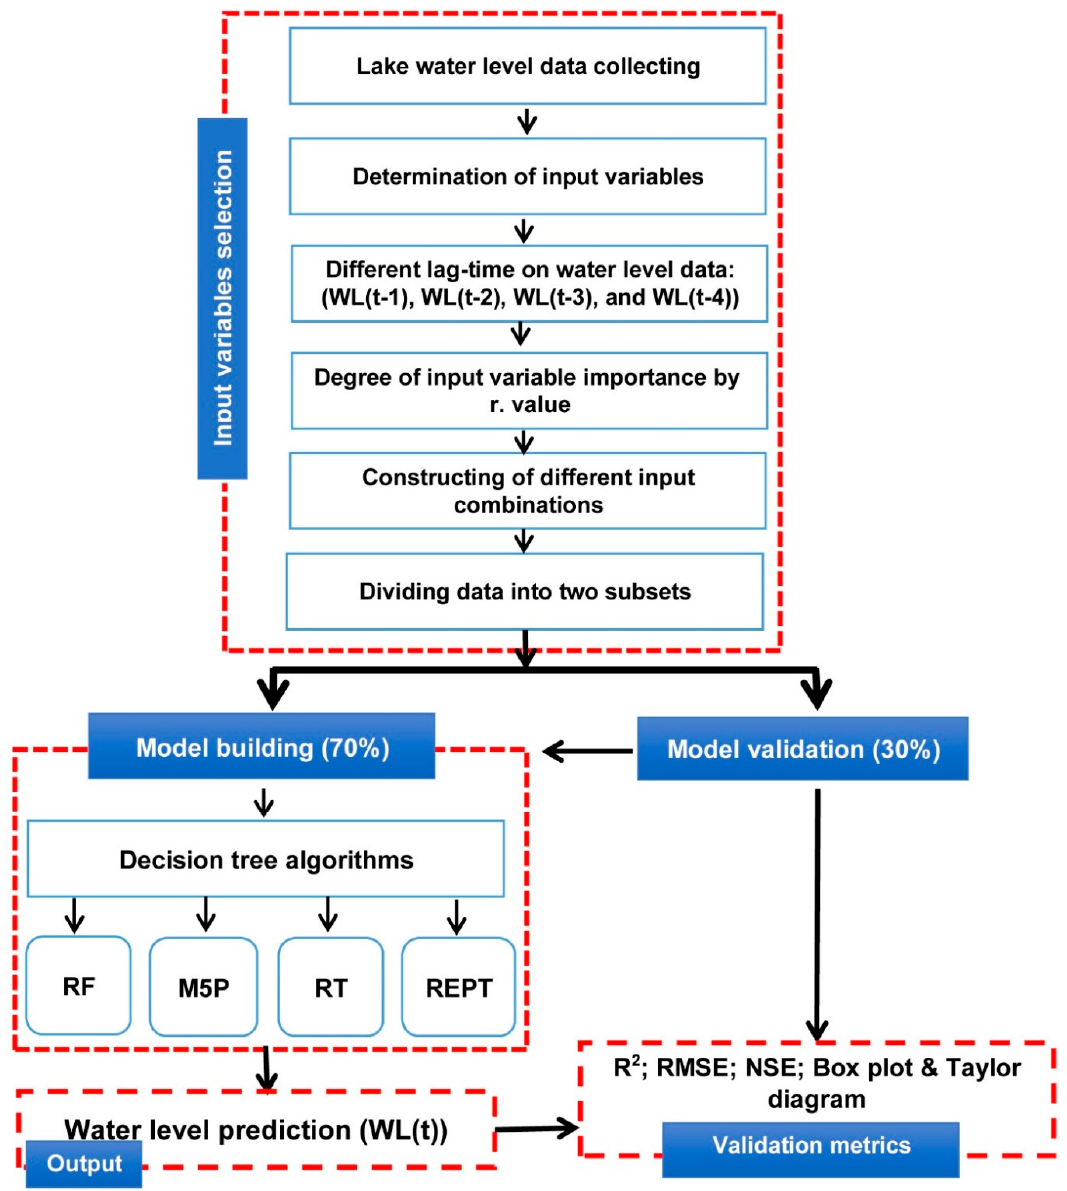
Figure 2. The flow diagram of the methodology.